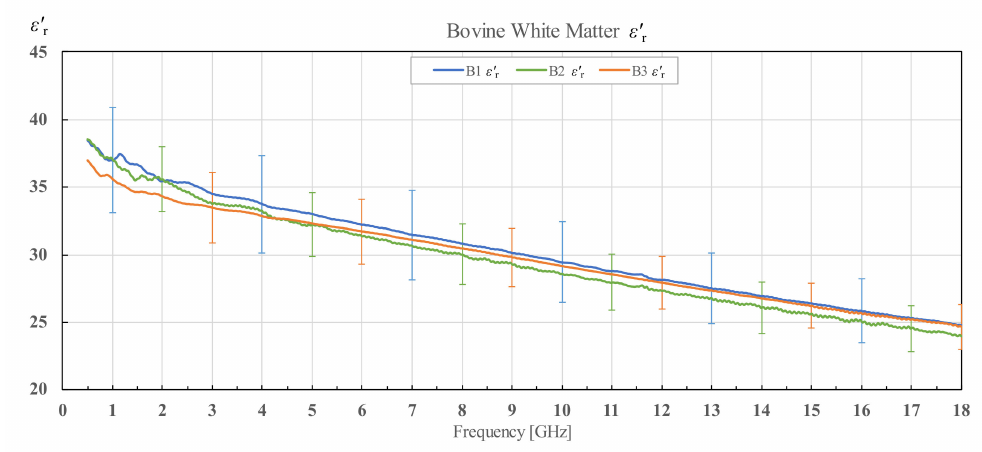
Figure 9. Real part of permittivity of bovine white matter for brains B1, B2 and B3 with associated standard deviations.